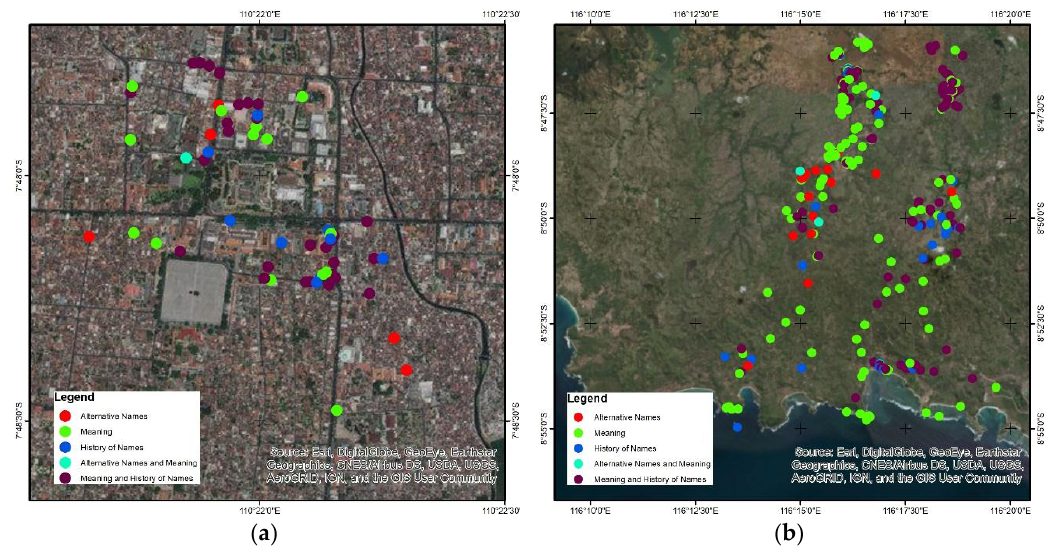
Figure 4. Toponyms with alternative names, meaning, and history of names: ( a ) urban names in the case study of Yogyakarta provided 63 toponyms; ( b ) natural and man-made features in the case study of Lombok provided 367 toponyms.